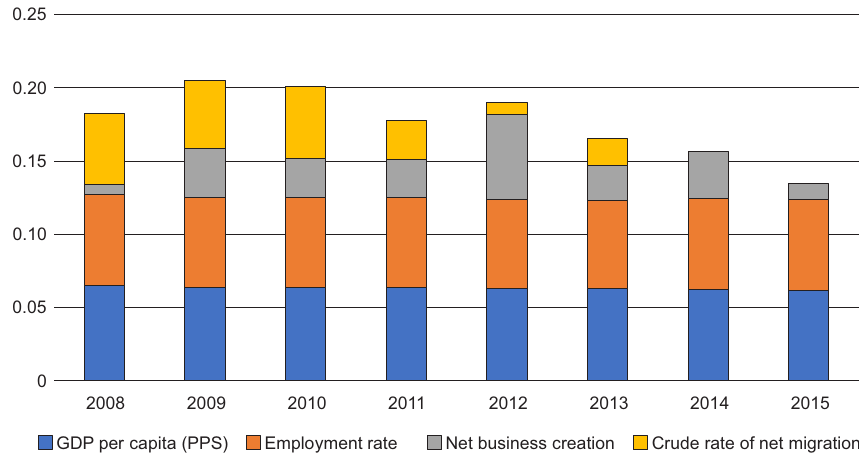
Fig. 5. Raw breakdown for indicators of SSRR index for Alentejo Central, 2008 to 2015. Source: own calculations using data from